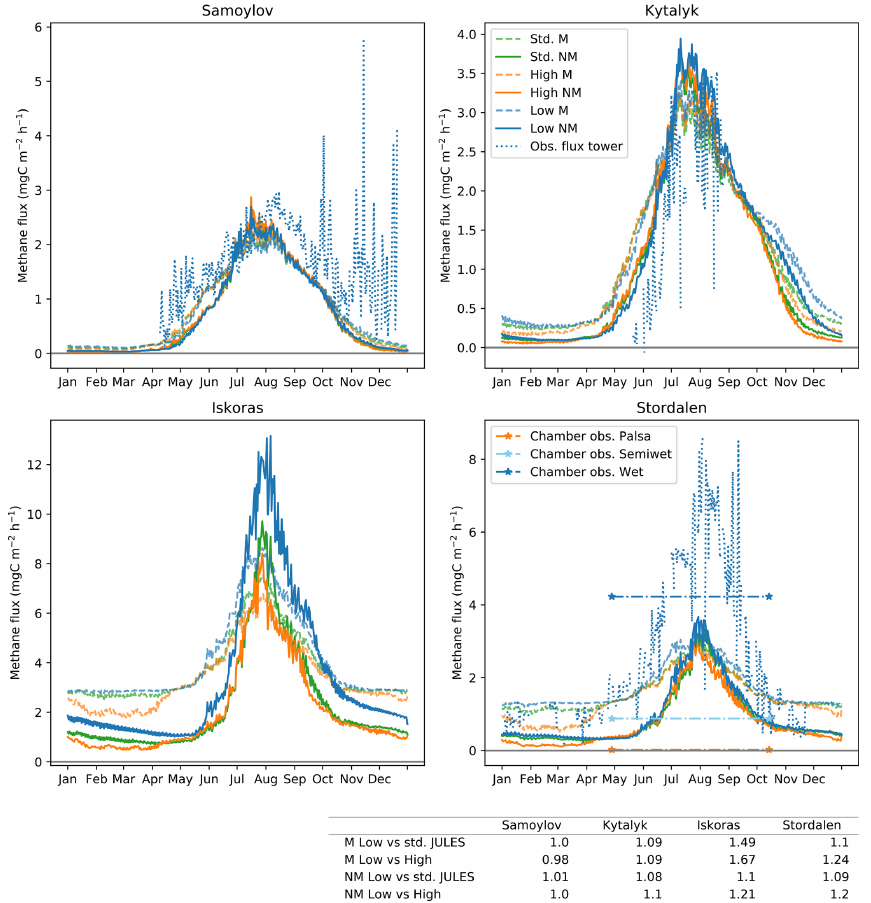
Figure 13. Climatology (2000–2016) of diagnosed methane fluxes calculated using modelled soil temperatures and observed soil carbon profiles, comparing fluxes from standard JULES and the low tile. Diagnosed methane fluxes for the high tile are shown for comparison only, as the drier soil would inhibit methane fluxes from these tiles. M is used to indicate the microbial methane model, and NM is used to indicate the non-microbial methane model. Methane chamber measurements for Stordalen are for 2002–2007 for the green season (days 119–288) and indicate the variability in methane fluxes due to hydrological conditions and thaw present at the site (Bäckstrand et al., 2010). Here, standard JULES has qbase switched on while tiled runs have qbase